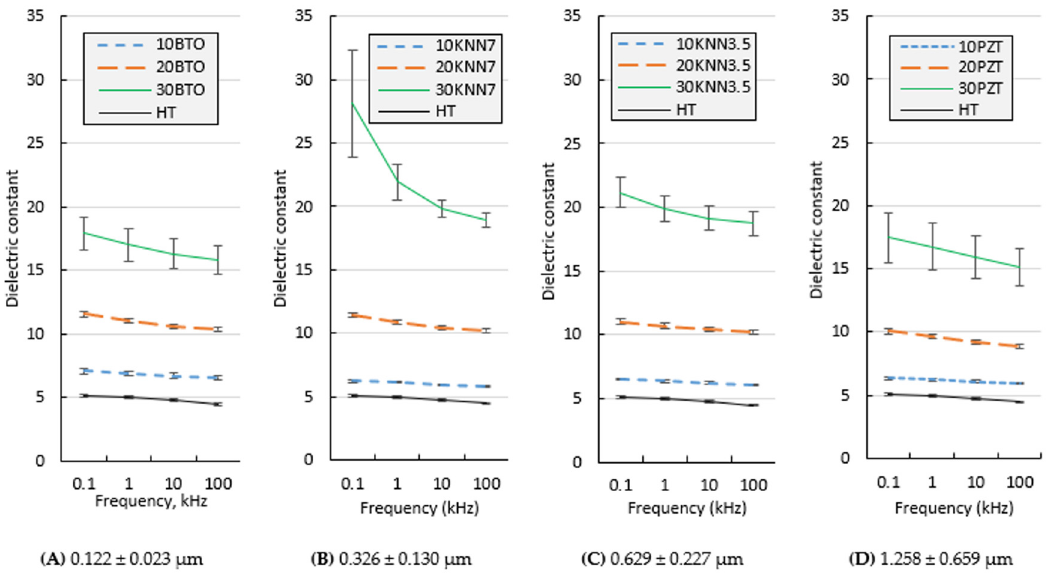
Figure 10. Dielectric constant values (relative permittivity) at different frequencies at room tempera-